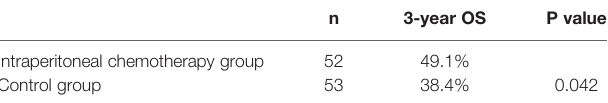
TABLE 3 | 3-year OS rate.